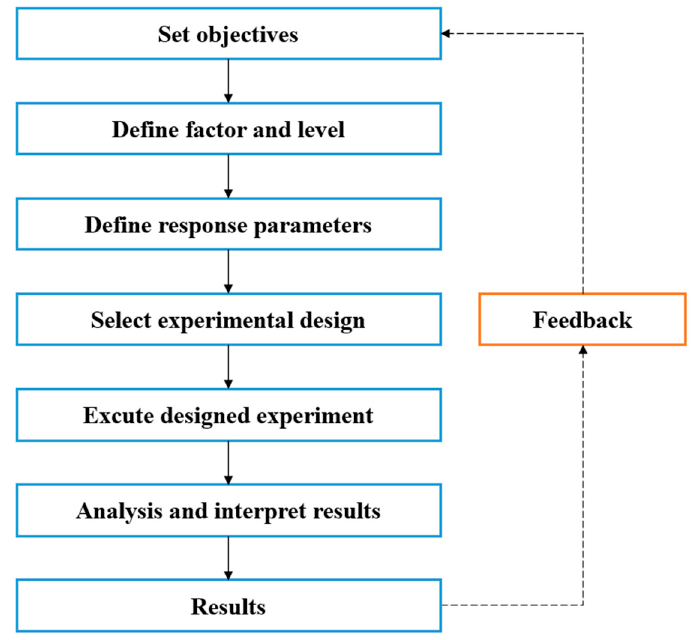
Figure 8. Design of experiments (DOE) flow chart.